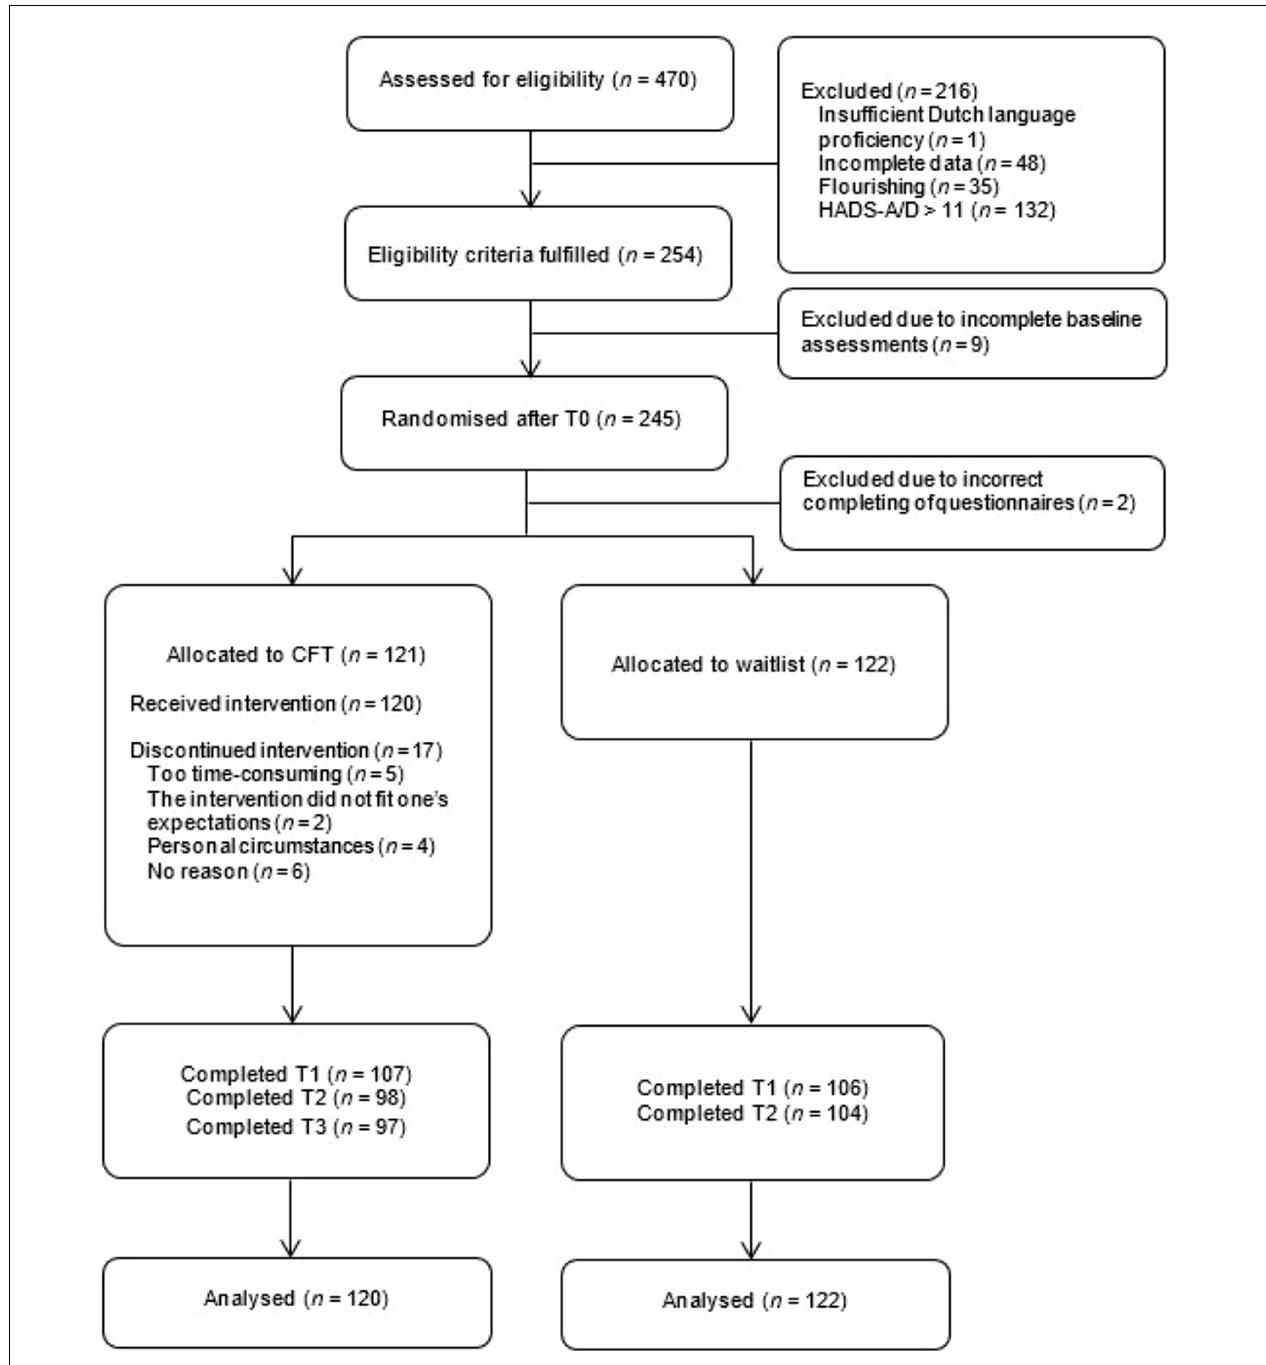
FIGURE 1 | Flowchart of study participants and dropouts.